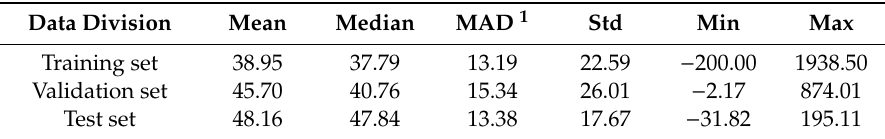
Table 1. Descriptive statistics of the